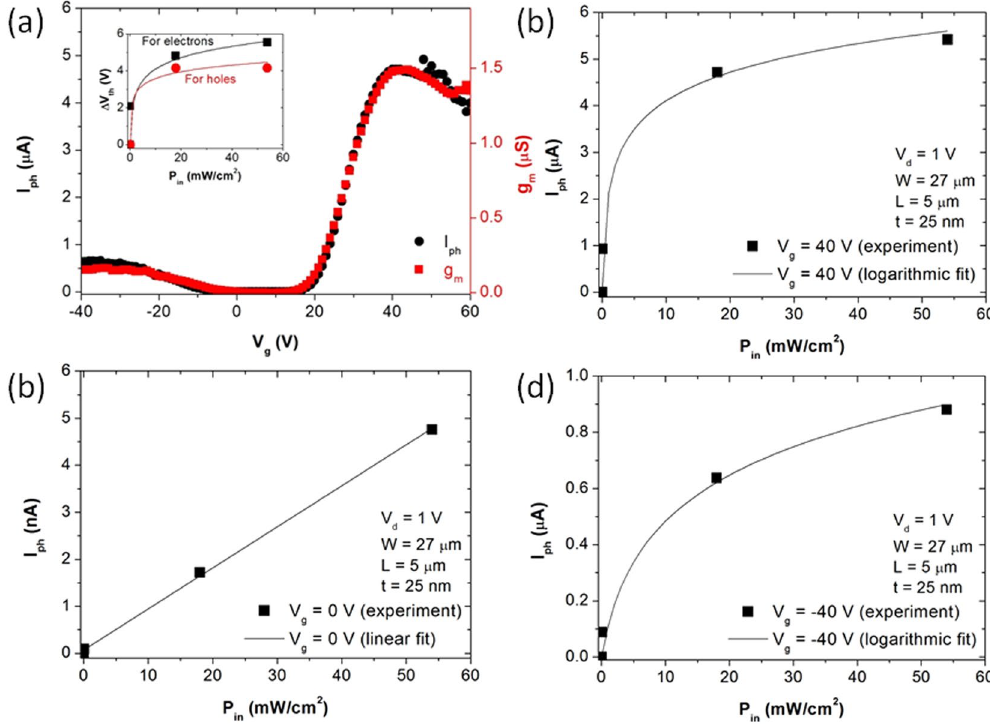
Figure 2. ( a ) I ph and g m as a function of V g ; inset shows Δ V th for electrons and holes as a function of P in (solid lines: logarithmic fit); I ph as a function of P in ( b ) at V g = 40 V, ( c ) at V g = 0 V, and ( d ) at V g = − 40